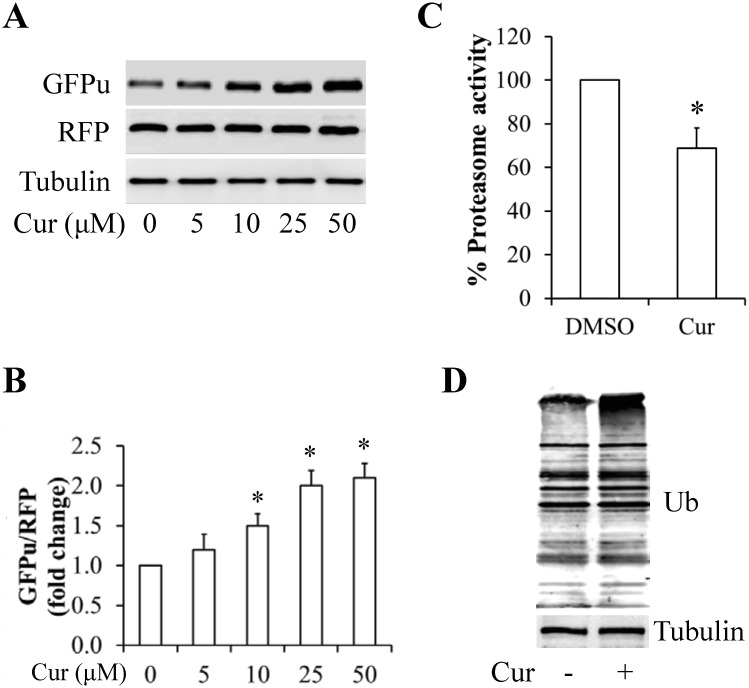
Effect of curcumin on the ubiquitin proteasome system.(A) GFPu expression. (B) GFPu/RFP ratio in (A) was analyzed quantitatively in a bar graph. (C) Proteasomal chymotrypsin-like peptidase activity. (D) Total protein ubiquitination. Data are means ± SEM. (n = 4). * p<0.05 vs DMSO control.